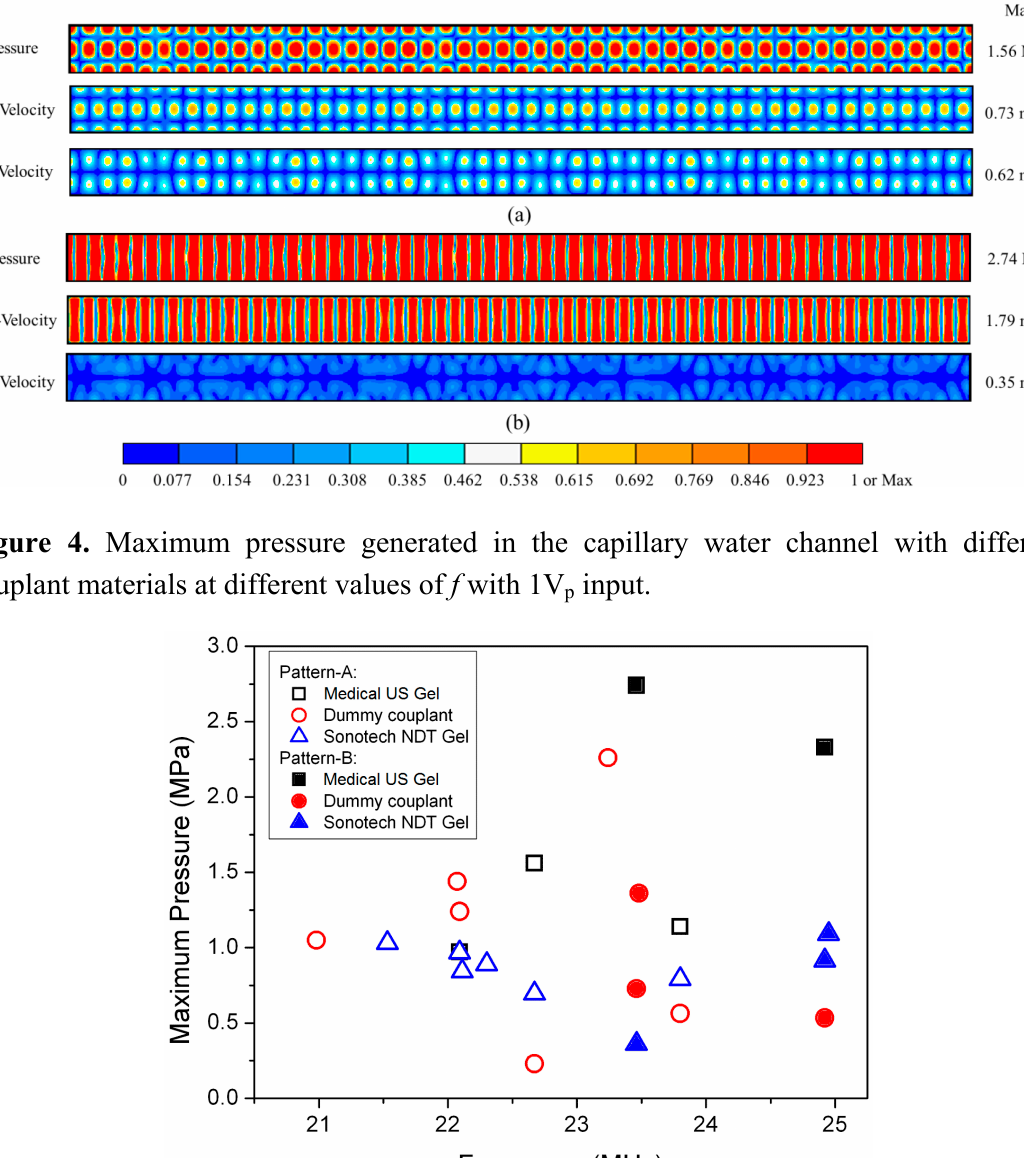
( a ) 22.67 MHz and ( b ) 23.46 MHz with 1 V